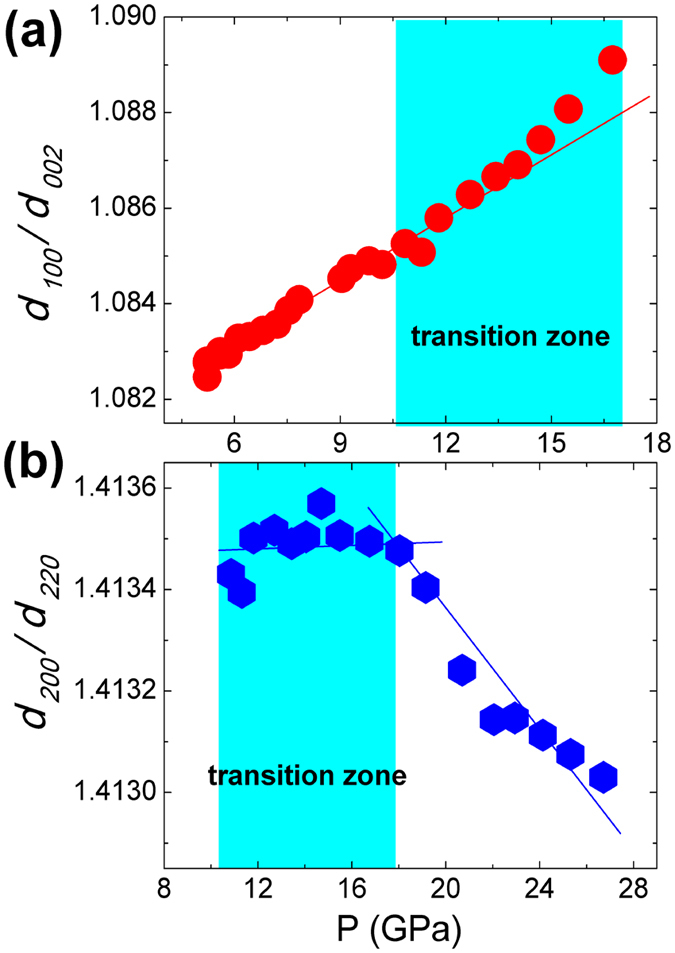
Pressure dependencies of ratio d100/d002 for wurtzite phase (a) and ratio d200/d220 for rocksalt phase (b). The straight lines guide for eyes.